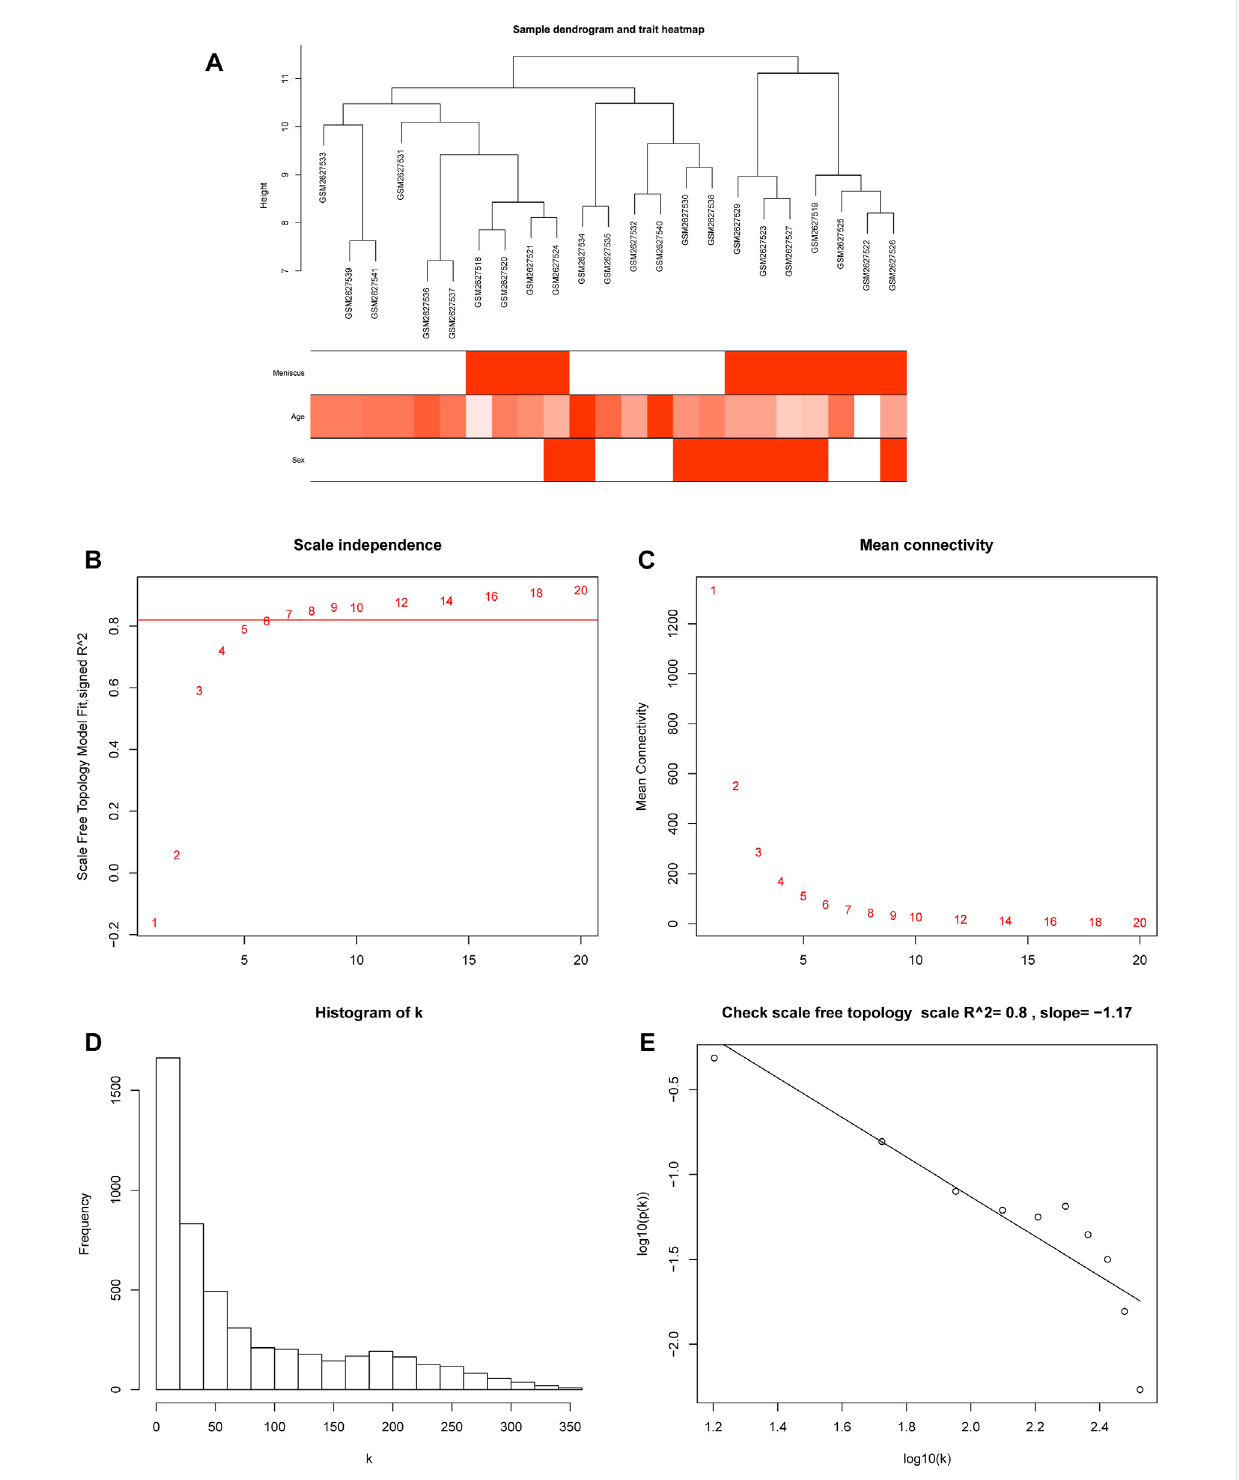
FIGURE 1 Sampleclustering andsoftthresholdscreening. (A) Heatmapofsampleclusteringandclinicaltraits. (B) Analysisofthescale-free fi tindexfor various soft-thresholding powers ( β ), and 6 was the most fi t power value. (C) Analysis of the mean connectivity for different soft-thresholding powers. (D) Histogram of connectivity distribution when β = 6. (E) Scale-free topology validation when β =